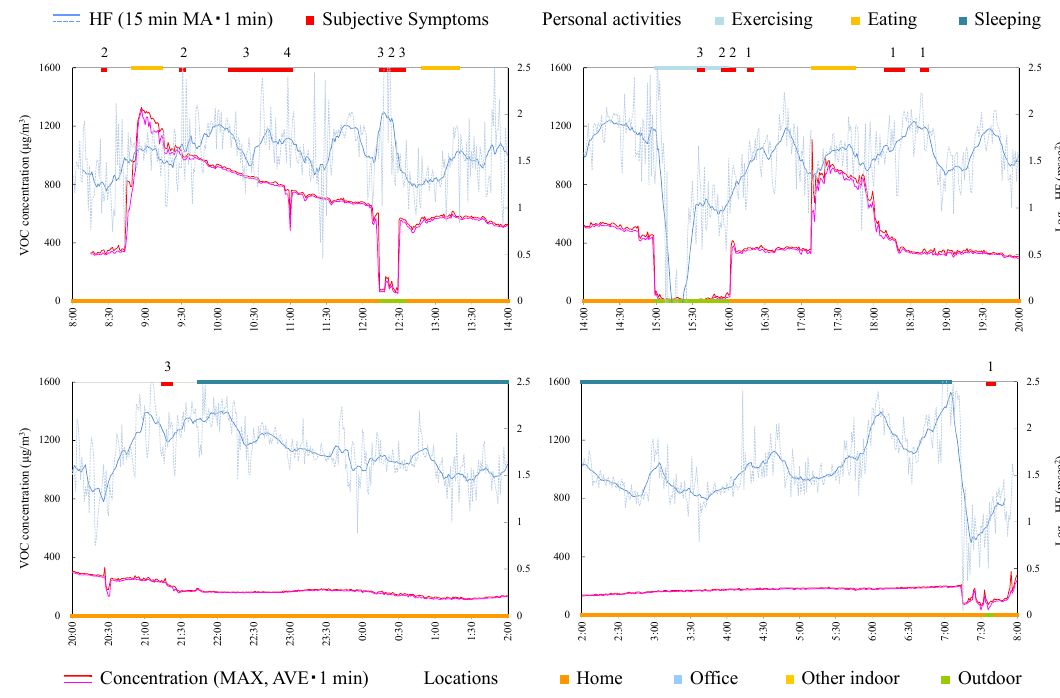
Figure 9. Time-series data of VOC concentration and log 10 HF (subject G). Subjective symptoms and personal activities are indicated in upper side and locations are indicated in lower side. The values on subjective symptoms are symptom levels.